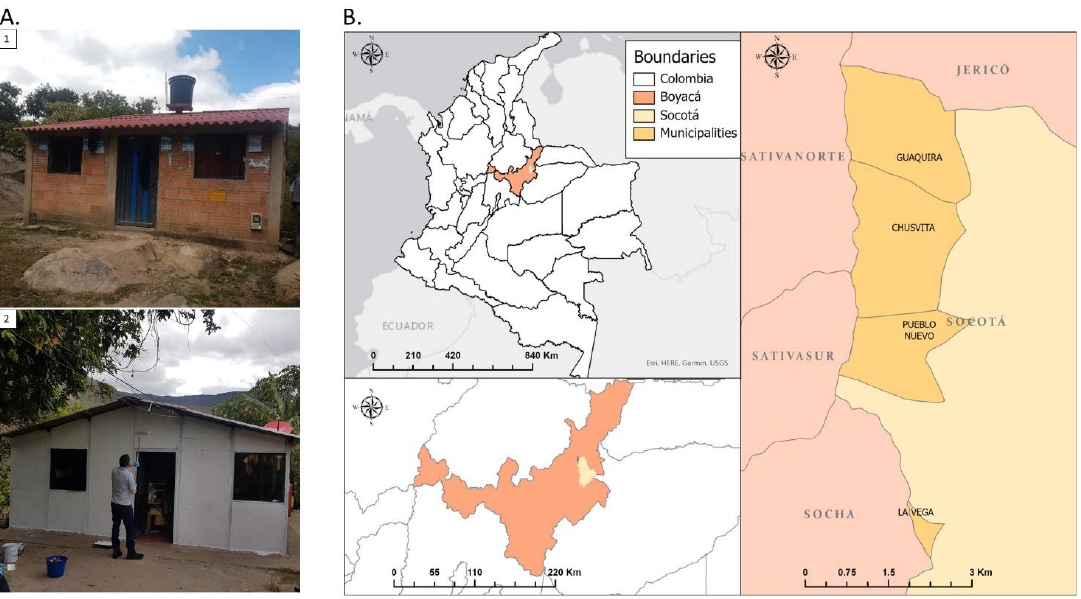
Figure 1. ( A ). Examples of selected households based on suitability before applying the paint (1) and after applying the paint (2). ( B ). Map of the selected municipalities from the Socatá region, Boyacá department, Colombia.